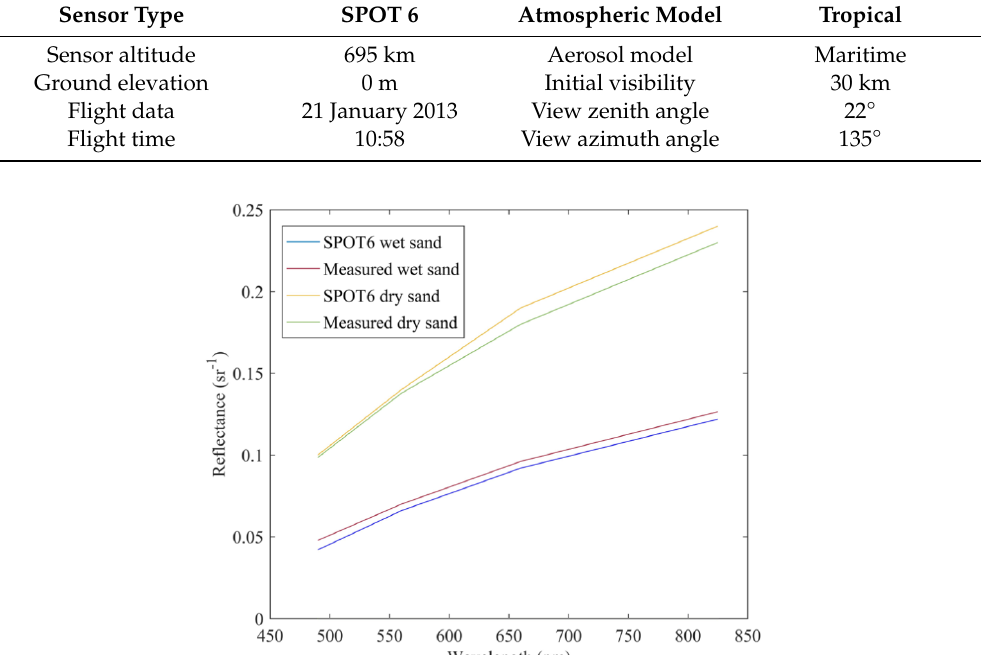
Table 4. Input parameters in fast line of sight atmospheric analysis of spectral hypercube (FLAASH).